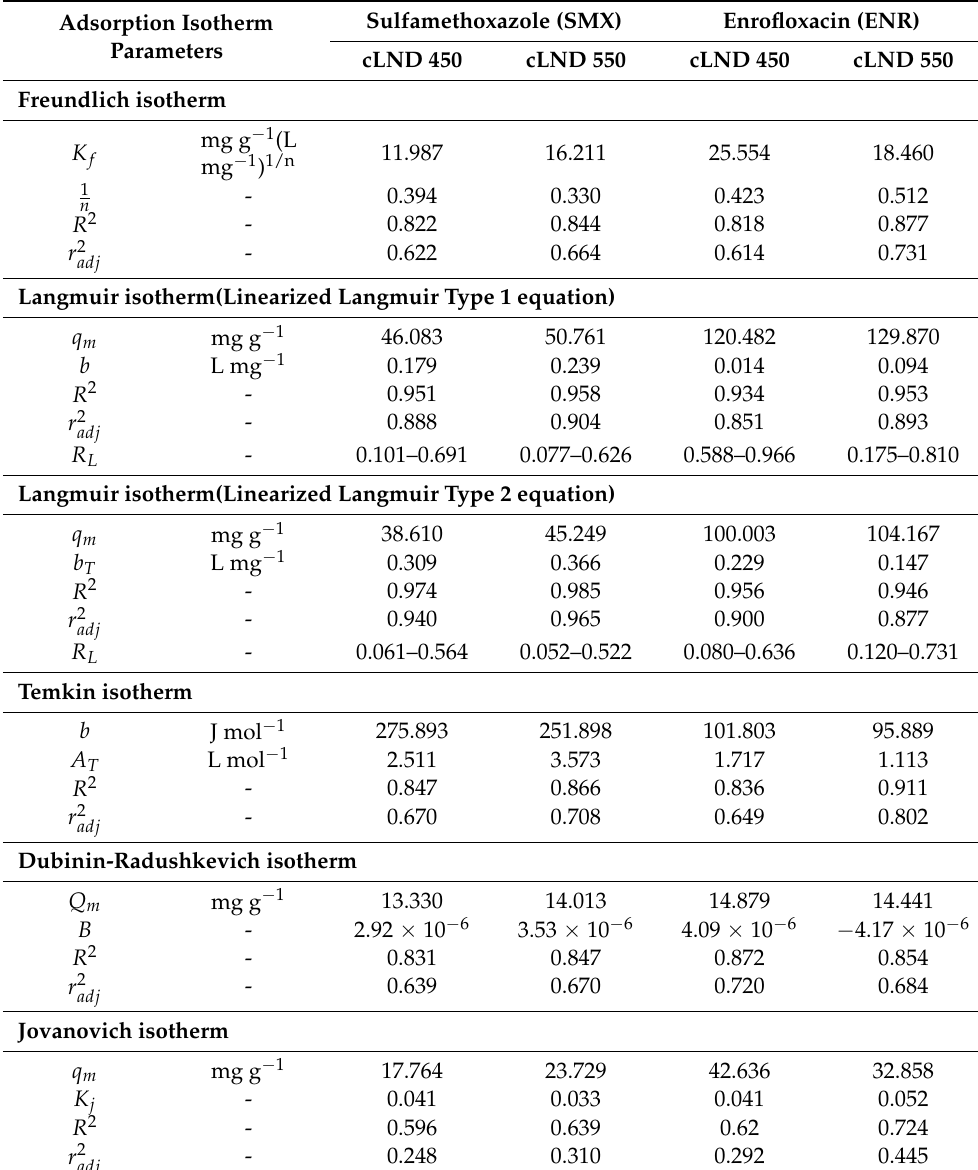
Table 2. SMX or ENR kinetic parameter comparisons for two types of cLND (cLND450 and